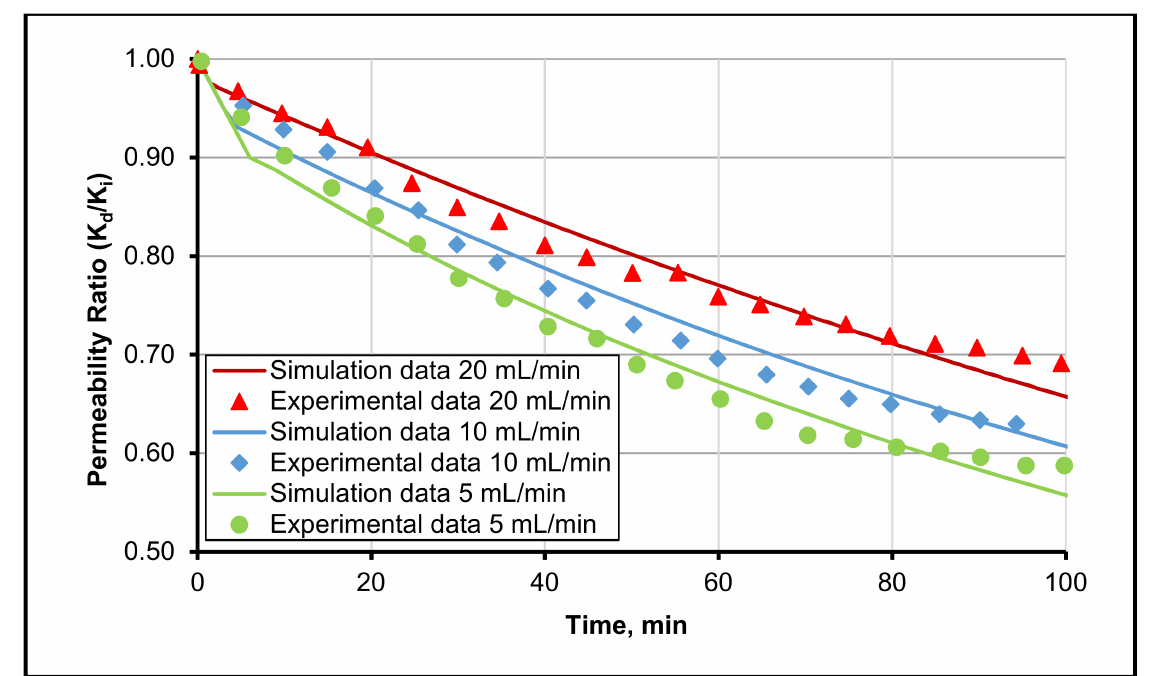
Figure 2. The variation in permeability ratio and comparison of simulation data with Khormali et al. [39] experimental